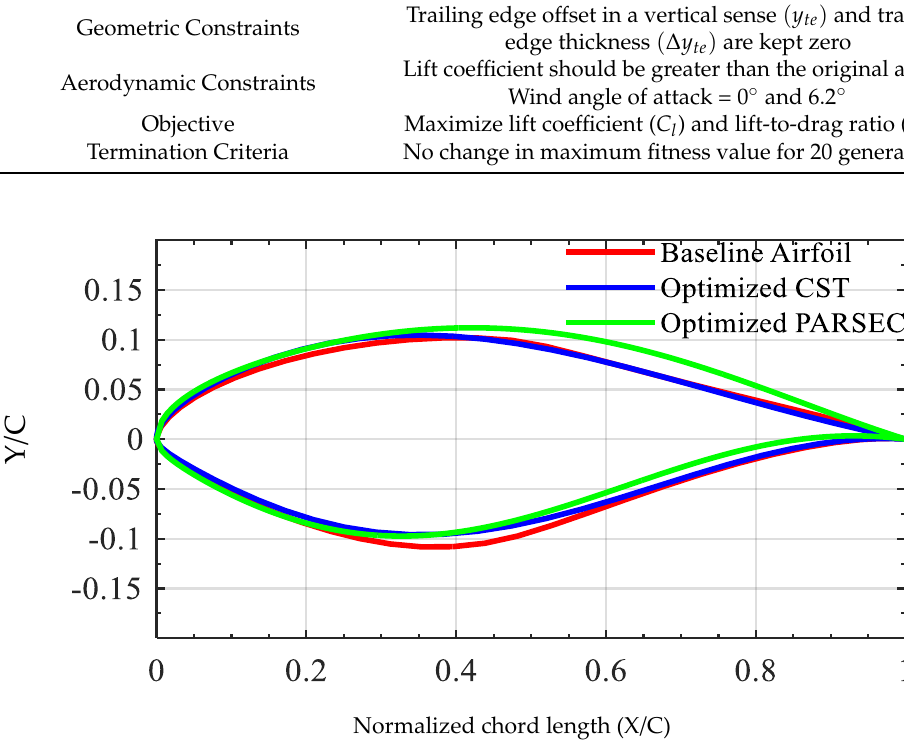
Figure 4. Optimized airfoil shape profile by a genetic algorithm (GA). Table 2. Optimization criteria and constraints.